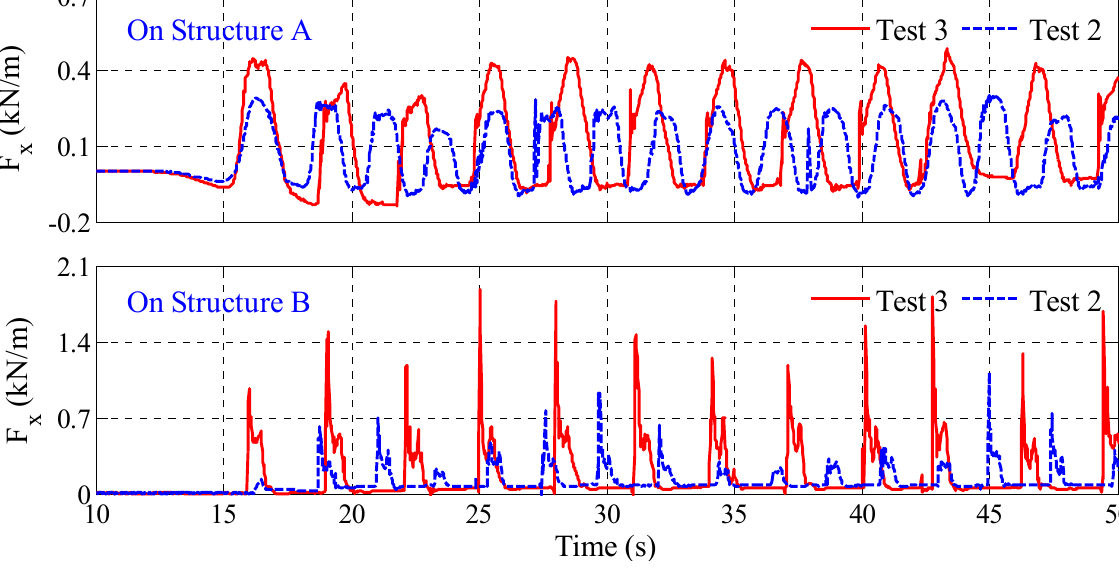
Figure 18. Comparison of wave impact force on structure A and B measured in Test 3 ( T = 3.0 s) and Test 2 ( T = 2.2 s).